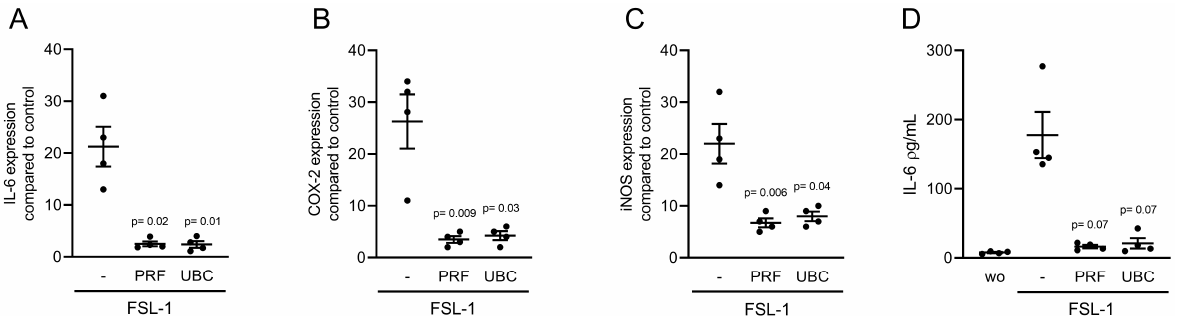
Figure 7. Lysates extracted from PRF or UBC can reduce TLR2/6 agonist-induced inflammation in RAW264.7 Cells . RAW264.7 cells were exposed to 30% lysates extracted from PRF and UBC membranes in the presence of 10 µg/mL FSL-1. ( A – C ) The data show the x-fold changes in IL-6, COX-2 and iNOS gene expression ( D ) and IL-6 levels in the cell supernatant, n = 4. Statistical analysis was based on uncorrected Dunn’s tests, and p values are indicated compared to the FSL-1 group. Significance was set at p < 0.05.